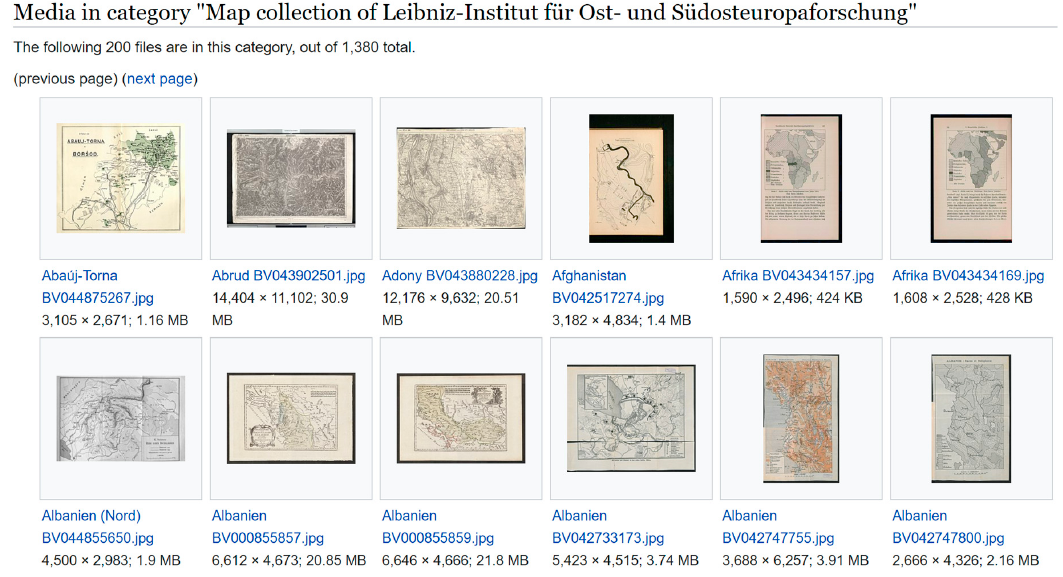
Figure 3. Collection of Leibniz Institute for East and Southeast European Studies available via Wikimedia commons [44].